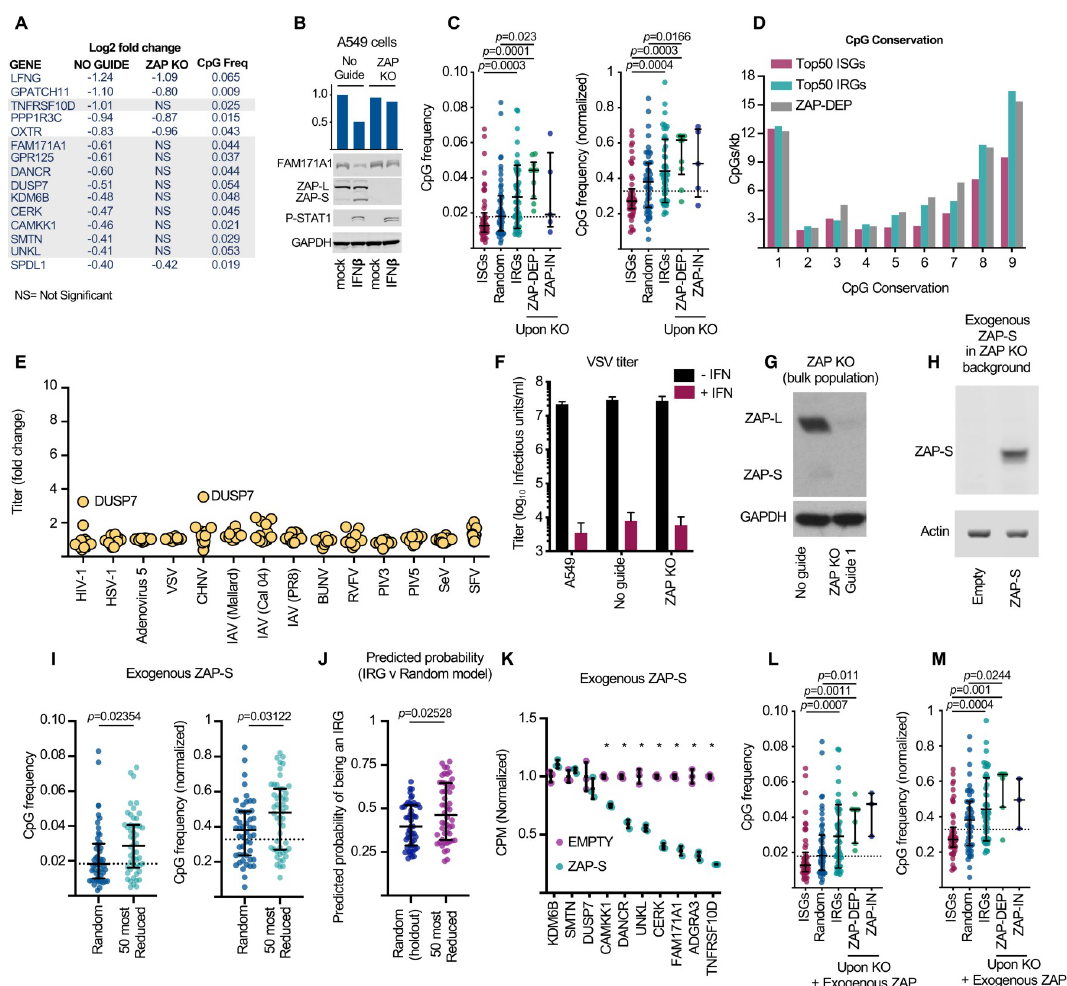
Fig 5. Identification of host transcripts consistently targeted by IFN-stimulated ZAP. (A) The identity and differential expression of the 15 IRGs identified in Shaw et al. [4], as well as in bulk and clone NO GUIDE controls (derived from the overlapping populations, left-hand side of panel B in S8 Fig). Shaded genes represent IRGs whose repression is not observed following ZAP KO. (B) WB of FAM171A1, ZAP, P-STAT1, and GAPDH in A549 NO GUIDE or ZAP KO clones stimulated with 1,000 units/ml of IFN β (24 hours). (C) The CpG contents of 10 ZAP-dependent (ZAP-DEP) IRGs and 5 ZAP-independent (ZAP-IN) IRGs (identified in A) are shown alongside the most DE ISGs and IRGs from Fig 2A. Significance was assessed using the Kruskal–Wallis rank sum test; significant differences are shown (all comparisons listed in S9 Fig). (D) CpG conservation among 9 primate species (as in Fig 3C–3E) is plotted as the number of CpGs per kb, binned by the number of species that possess that specific CpG, where 1:1 orthologs exist (ZAP-DEP n = 5). “1” represents CpGs present in only 1 of the species, whereas “9” represents CpGs conserved in all of the 9 species considered (top 50 ISGs includes 30 1:1 orthologs and top 50 IRGs includes 34 1:1 orthologs). (E) The 10 putative ZAP targets (identified in A) encoded by lentiviral vectors were used to transduce human cells prior to serially diluted challenge with a GFP- expressing virus. The resulting titres were calculated using flow cytometry and normalised to the empty vector control. These data were plotted as the fold change in titre (y-axis) relative to the empty vector control cells (yellow circles represent each cDNA). (F) The impact of ZAP KO (see Materials and methods) on the replication of Indiana vesiculovirus in the presence and absence of IFN β . (G) WB for ZAP in bulk A549 cells KO’d for ZAP (ZAP KO guide 1) compared to mock treated cells (No guide). (H) WB of A549 ZAP KO cells (guide 1, clone 2; Fig 4C) transduced with an empty lentiviral vector or a lentiviral vector encoding CRISPR-resistant ZAP-S. (I) The transcriptomes of the transduced cells in (H) were defined using RNA-seq and the CpG compositions of the 50 most downregulated transcripts are shown. Significance was determined using the Wilcoxon rank sum test with continuity correction. (J) The predicted probability that the most reduced transcripts in (I) are IRGs. A sample of 50 random genes (not used for training) are included as a comparator. Significance was determined as in (I). (K) The transcript abundance of the 10 ZAP targets identified in (A) in the cells from (H) and (I) is shown. (L) The CpG frequency and (M) normalised CpG frequency of the 7ZAP-DEP IRGs and 5 ZAP-independent (ZAP-IN) IRGs (identified in A and J) are shown alongside the most DE ISGs and IRGs from Fig 2A. Significance was assessed as in (C). The dashed line in (C), (I), (L) and (M) represents the median CpG frequency of all transcripts in the genome, a random sample of non-DE genes is included for reference, and whiskers represent the median and interquartile range for the analysed group. The underlying data from this figure are openly available (http://dx.doi.org/10.5525/gla.researchdata.1159). BUNV,